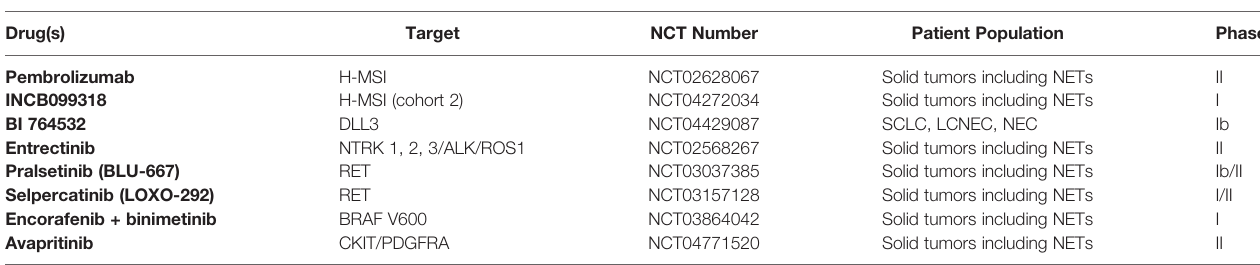
TABLE 2 | Ongoing molecular-driven clinical trial involving high-grade